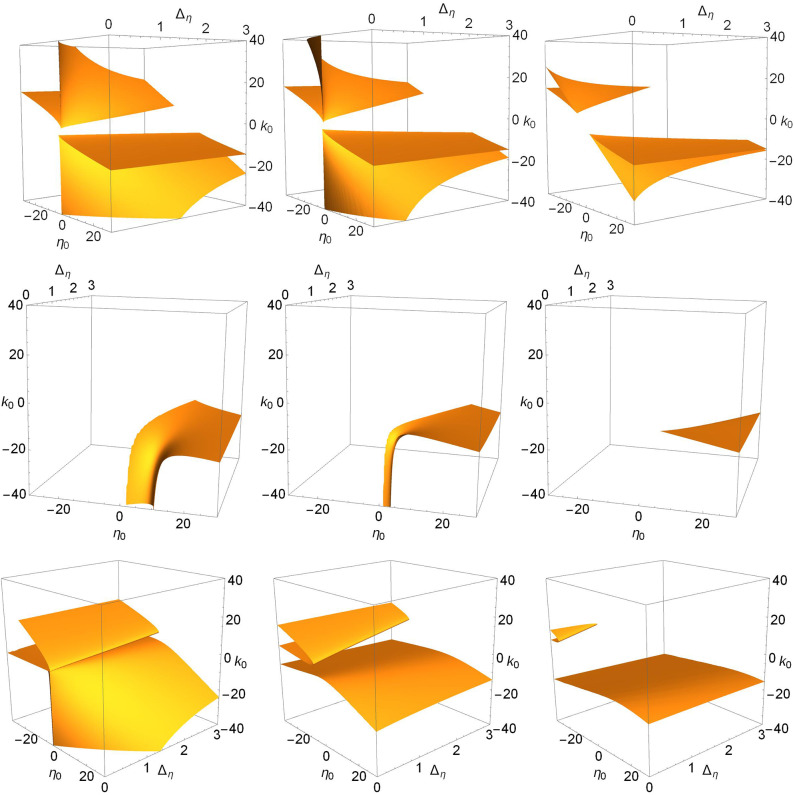
The surfaces for n = 9, for which the synaptic pulse (Equation 2) is much narrower. (Top) The saddle-node surfaces for Δk = 0.0, 1.0, 2.0. (Middle) The Hopf surfaces for Δk = 0.0, 1.0, 2.0. (Bottom) The node-focus surfaces for Δk = 0.0, 3.0, 5.0 (values chosen for visual clarity).